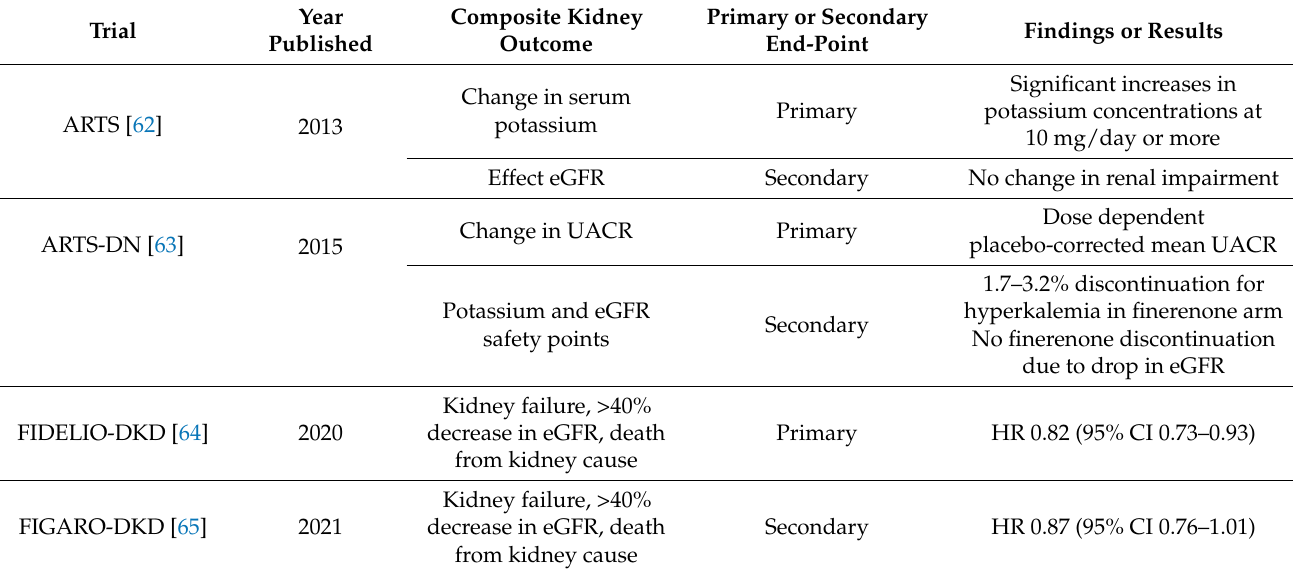
ARTS = Mineralocorticoid Receptor Antagonist Tolerability study; ARTS-DN = Mineralocorticoid Receptor Antagonist Tolerability Study Diabetic Nephropathy; CI = confidence interval; eGFR = estimated glomerular filtration rate; FIDELIO-DKD = The finerenone in reducing kidney failure and disease progression in diabetic kidney disease; FIGARO-DKD = finerenone in reducing cardiovascular mortality and morbidity in diabetic kidney disease; HR = hazard ratio; UACR = urine albumin to creatinine